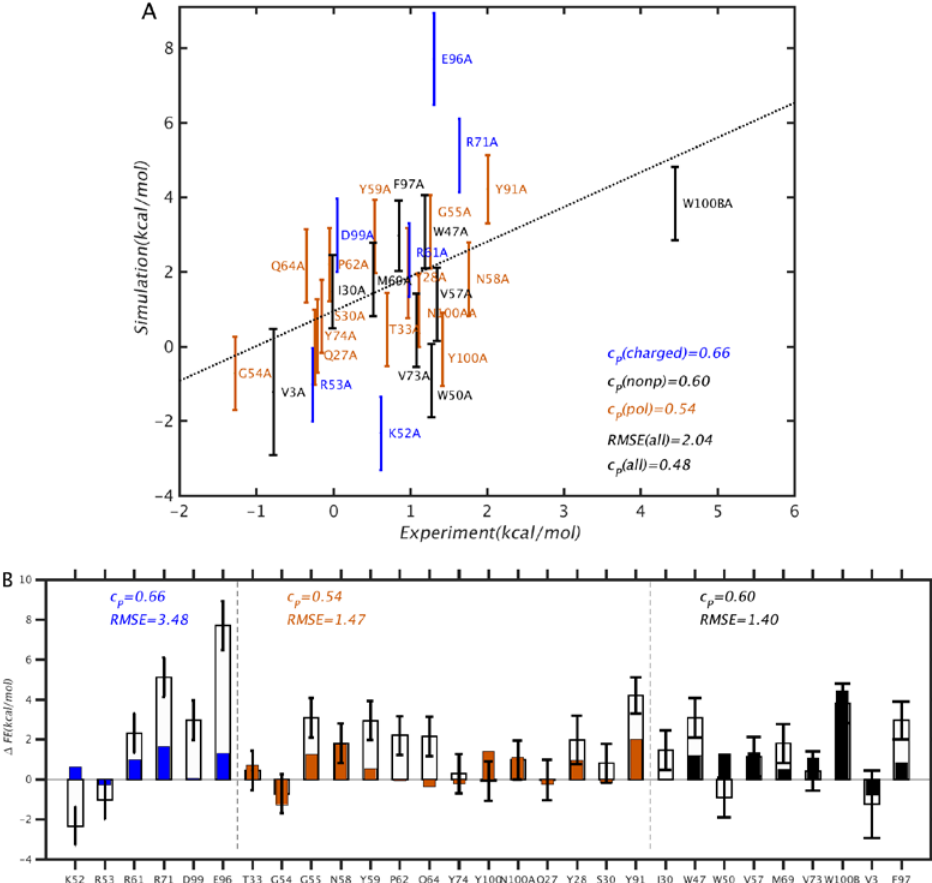
Figure 3. Comparison between binding free energy (bFE) differences computed from PMF simulation results and experiment. In ( A ), mutations corresponding to charged, polar, and nonpolar residues are colored in blue, brown, and black, respectively, and the dotted line corresponds to y = x. In ( B ), the mutation data are compared individually. Residues V3, Q27, Y28, S30, Y91, E96, and F97 are in the Ab light chain, and the remaining ones are in the heavy chain. The filled and unfilled bars correspond to experiment and simulation, respectively.